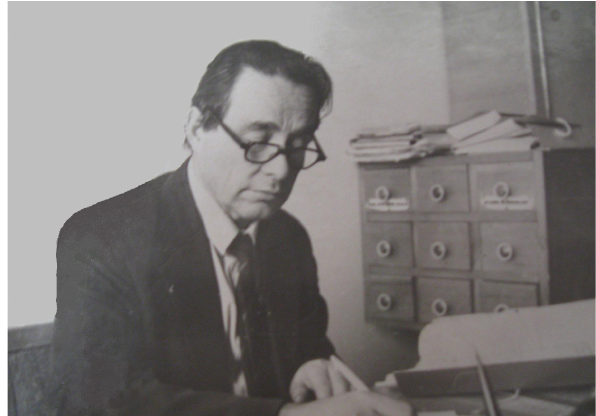
Figure 1. Dr. V. I. Taran.